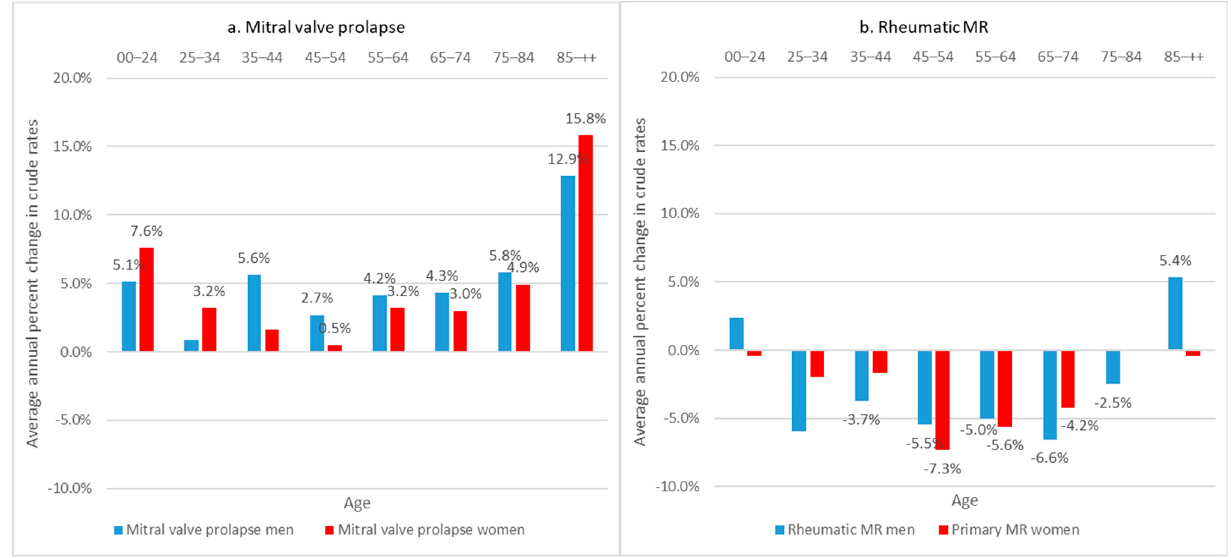
Figure 2. Average annual percent change in crude rates of patients hospitalized for primary mitral regurgitation, according to etiology and sex, France, 2006–2019. Only values significantly different from 0% are presented (alpha risk = 5%) . 0% are presented (alpha risk = 5%)